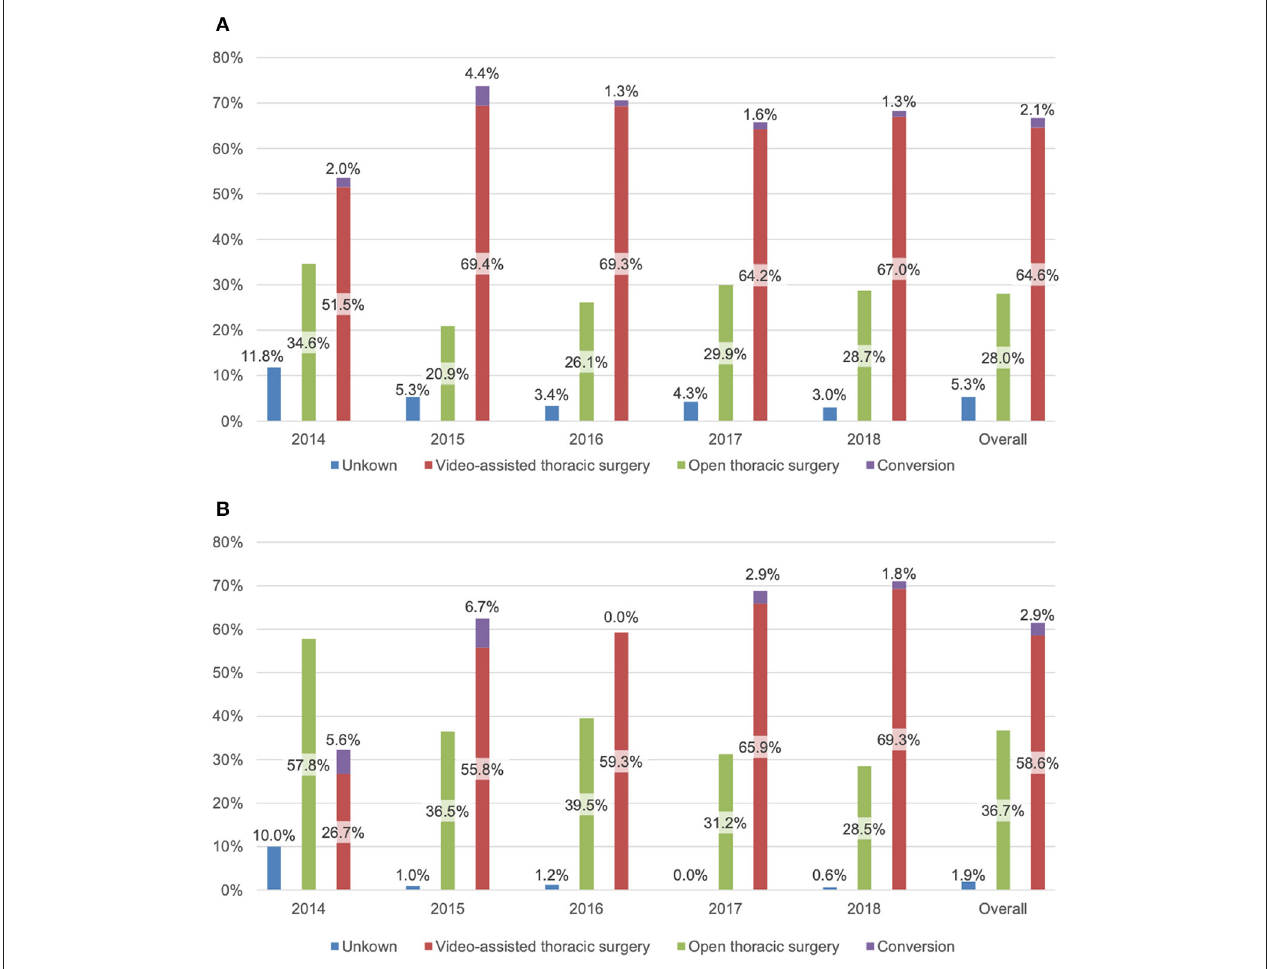
FIGURE 2 | Access type (%) for (A) 2,430 patients undergoing thoracic surgery and (B) 700 patients undergoing anatomical